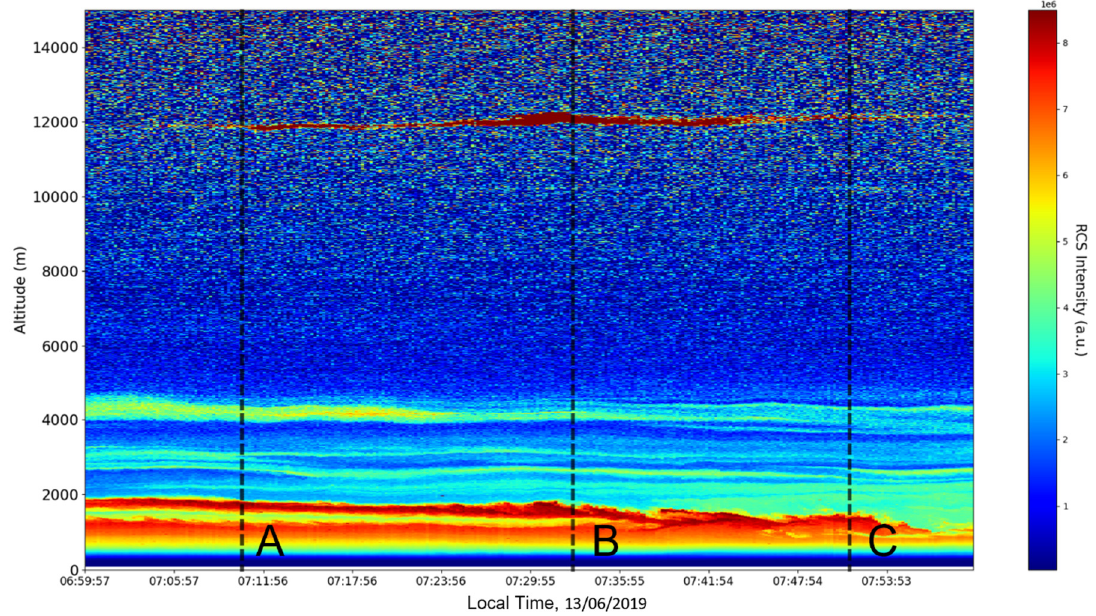
Figure 1. RCS timeseries, Bucharest, Romania, 13 June 2019.